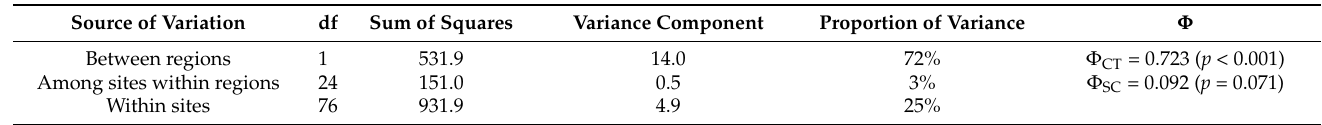
Table 3. Molecular variance analysis results for the populations of Aromia bungii in northern Kanto and southern